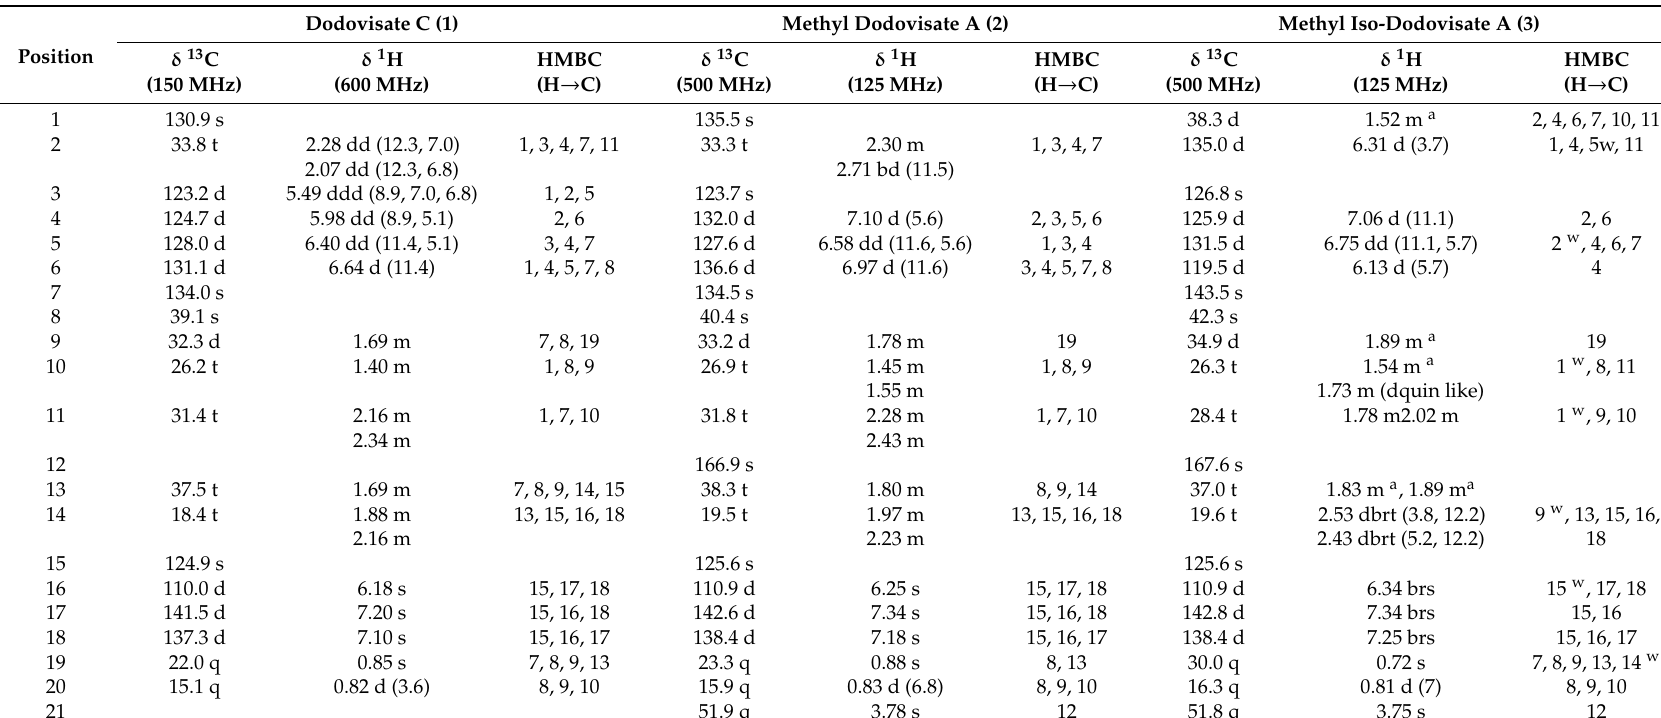
Table 2. 1D and 2D NMR spectroscopic data for dodovisate C ( 1 ), methyl dodovisate A ( 2 ), methyl iso-dodovisate A ( 3